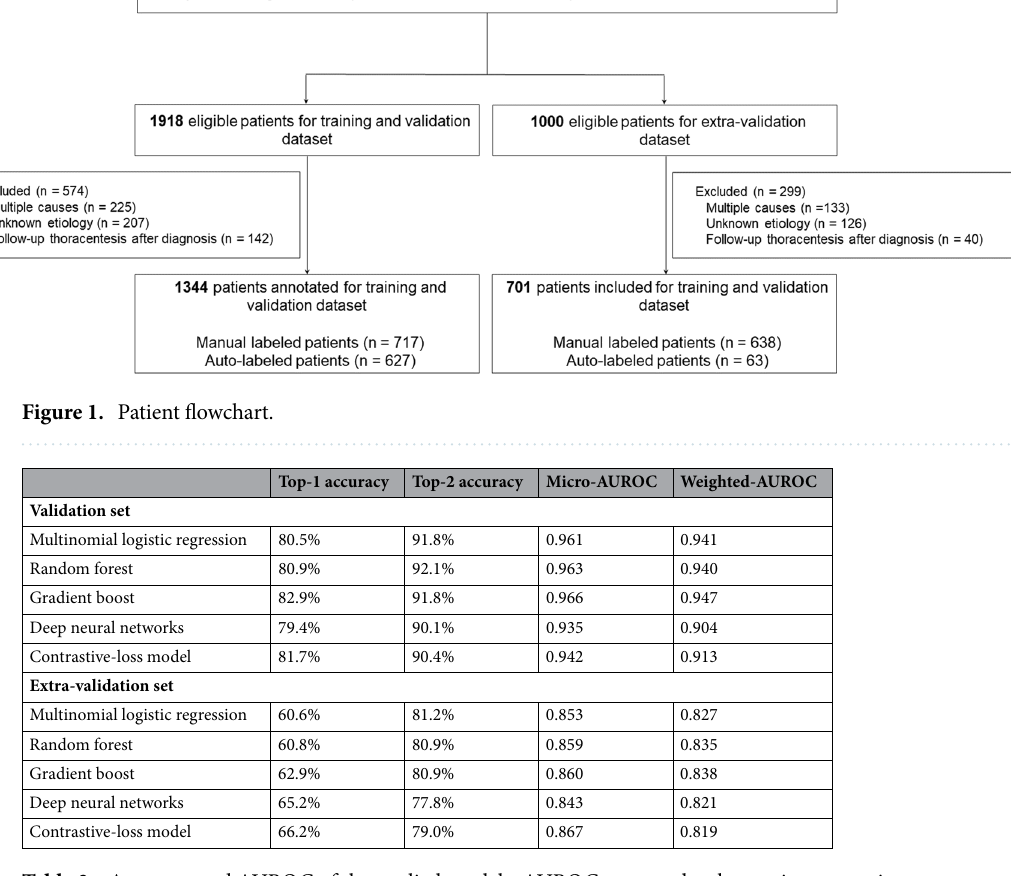
Table 2. Accuracy and AUROC of the applied models. AUROC: area under the receiver operating characteristic.